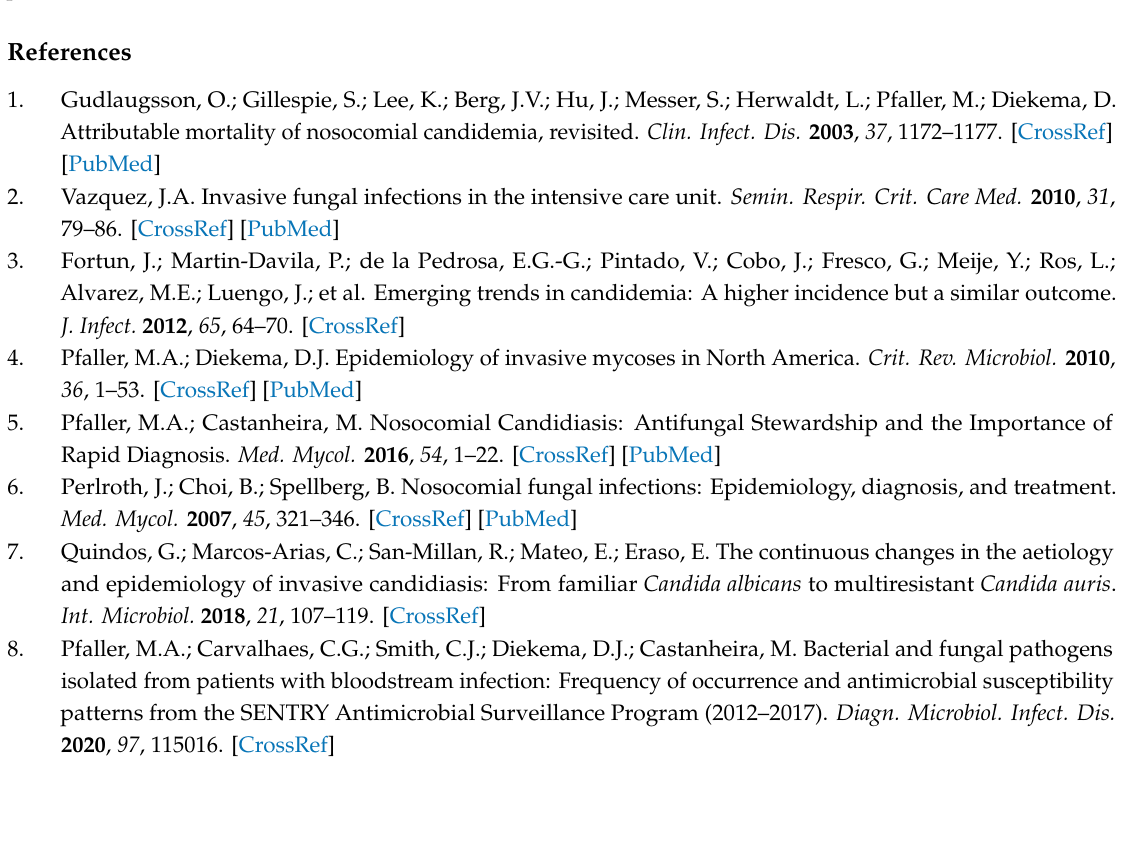
version. Figure S2: Quantification of the propidium iodide (PI) + cells after treatment with AMB and MF.